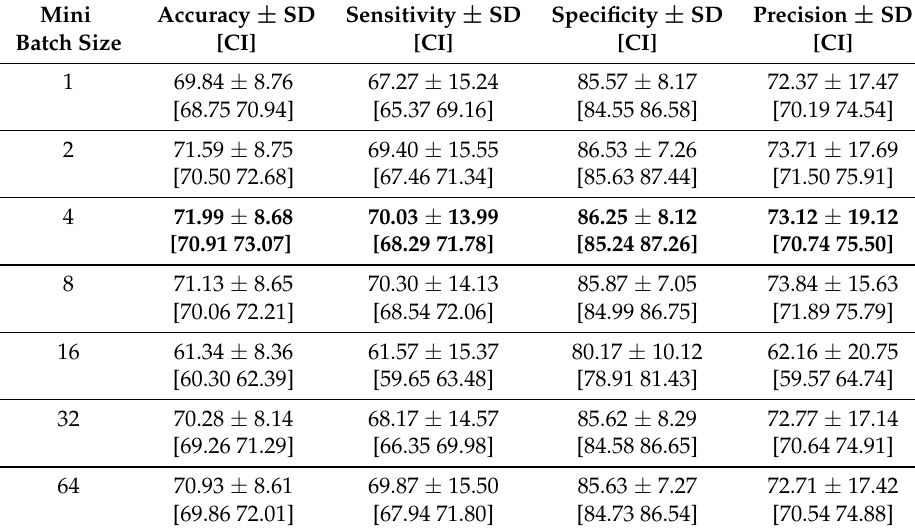
Table 4. Accuracy, Sensitivity, Specificity and Precision for Various Mini Batch Size Using LSTM. (The Numbers in Bold Indicate the Best Value Obtained for Each Quality